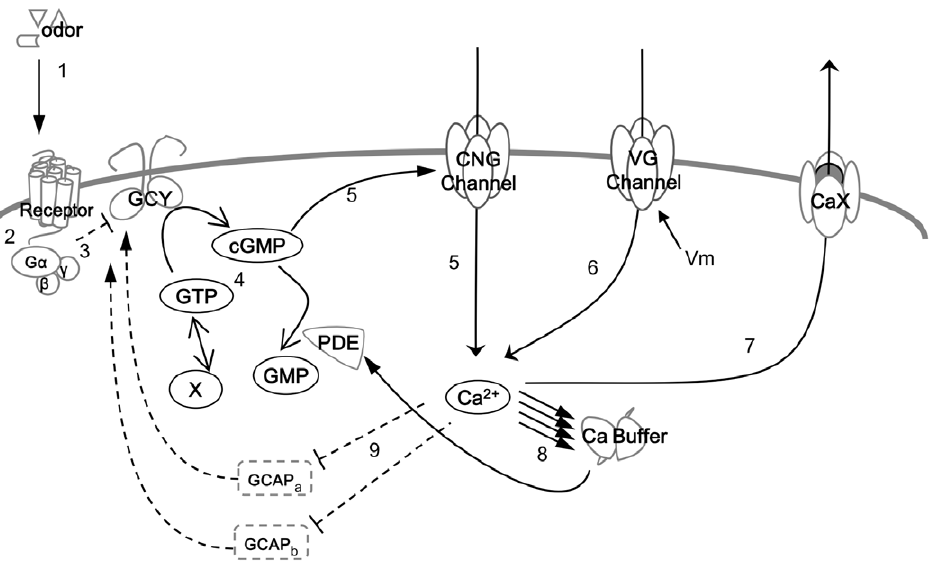
Figure 1. The hypothetical scheme of signal transduction. Reactions are classified into nine steps and numbered as reaction 1 thru 9. 1. Binding of an odor molecule to the receptor when odor stimulus is applied. Dissociation of an odor molecule from the receptor when odor stimulus is removed. 2. Activation of G-protein (G a subunit) following the bind of odor molecule to the receptor. Inactivation of G a subunit following an odor molecule dissociates from the receptor. 3. Inhibition of GCY by G a . This process includes binding of GCY and G a , GCY::GCAPa and G a , and GCY::GCAPb and G a . 4. Synthesis and decomposition of cGMP. These include cGMP synthesis by GCY, cGMP decomposition by PDE, and supply and removal of GTP by unknown process. 5. Binding of cGMP to the CNG channel, and changes in [Ca 2 + ] and membrane potential via the CNG channel. 6. Changes in [Ca 2 + ] and membrane potential via a voltage-gated channel (voltage-dependent calcium channel). 7. Change in [Ca 2 + ] via a calcium extrusion mechanism (CaX). 8. Binding of calcium ions to the calcium buffer (CaM), and modulation of CaX and PDE. 9. Inactivation of GCAPs by calcium ions and feedback on GCY activity.